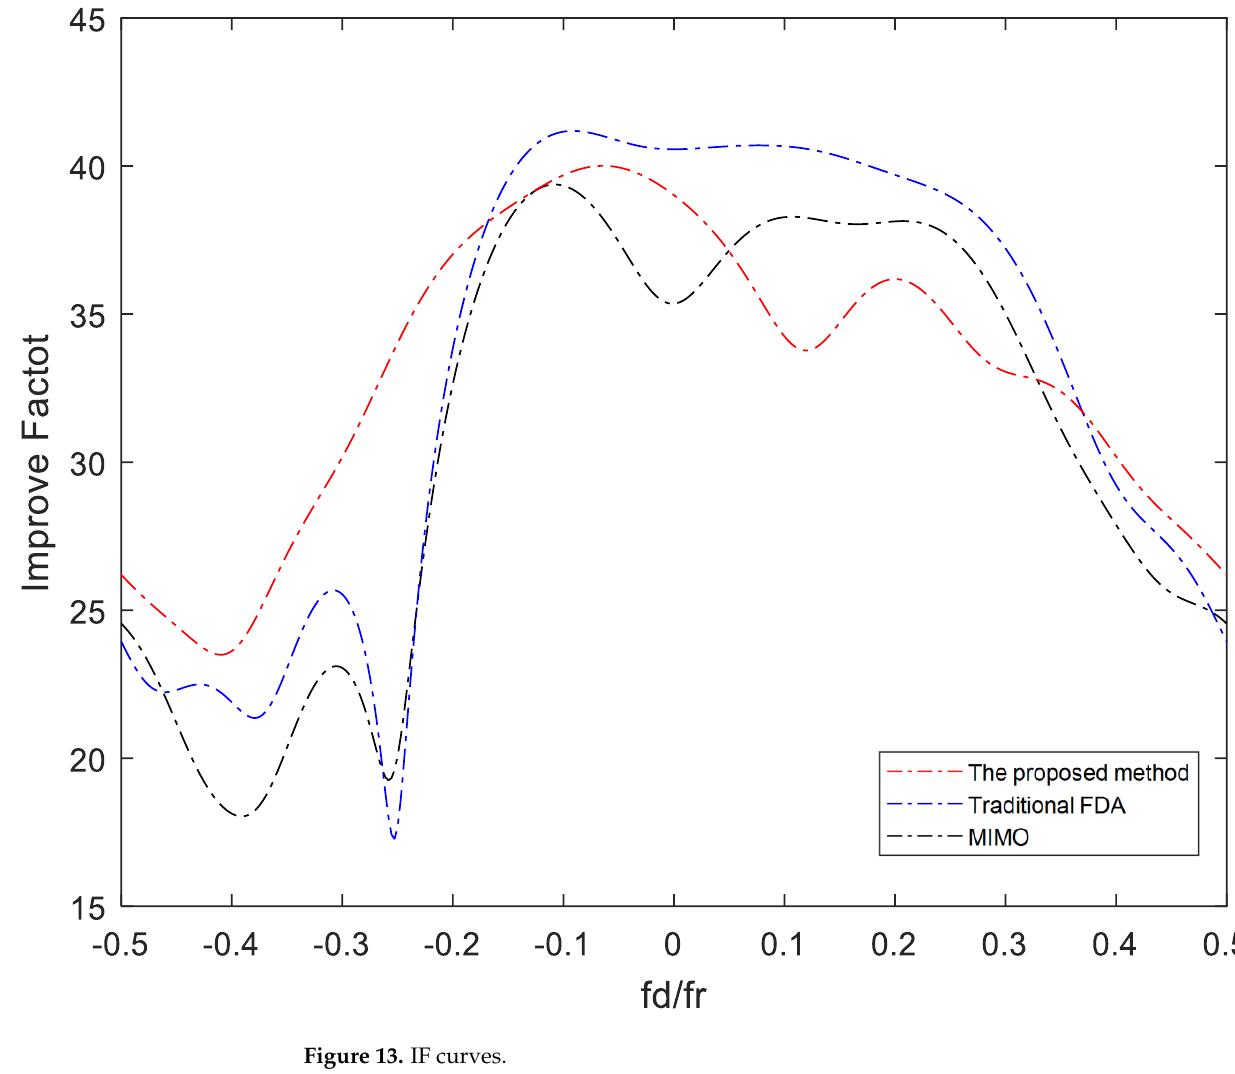
Figure 13. IF curves.